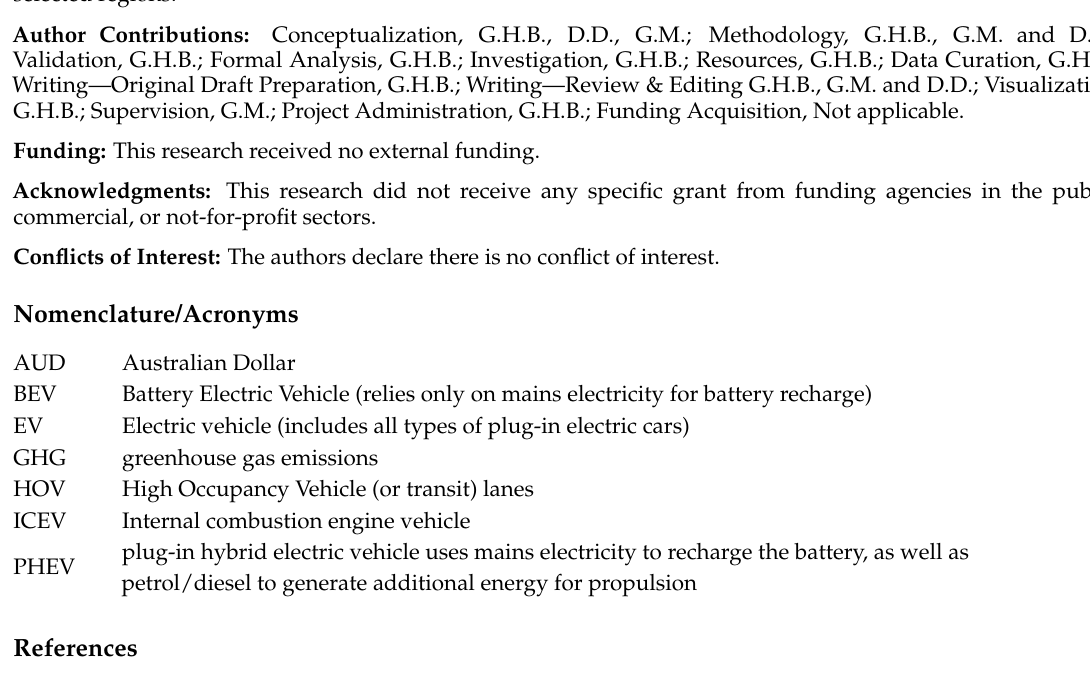
Figure S1: Factors that would encourage purchase of BEVs and PHEVs, Table S1: Questionnaire 1, question 27, Table S2: Questionnaire 1, question 28, Table S3: Questionnaire 1, question 32, Table S4: Questionnaire 1, question 35, Table S5: Questionnaire 1, question 37, Table S6: Questionnaire 1, question 38, Table S7: Questionnaire 2, question 10, Table S8: Questionnaire 2, question 14, Table S9: Concerns about EV uptake by ICEV motorists in selected